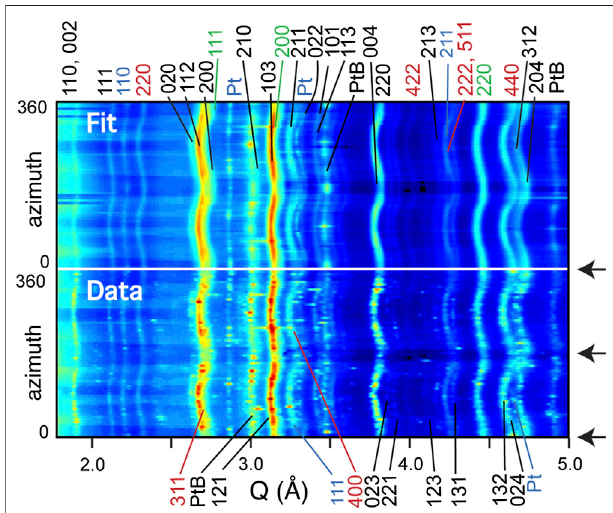
FIGURE 2 | “ Map-plot ” of spectra obtained by integrating the diffraction image in 5 ° azimuthal sectors and corresponding Rietveld re fi nement (top) . Map-plotisofimage172andwastaken in-situ at ∼ 39 GPaand1,000K.Black arrows indicate compression direction.Pt,PtBpeaks arelabeled.Peaks for stishovite shown in blue, ringwoodite in red, and ferropericlase in green. Black labeled peaks are bridgmanite.